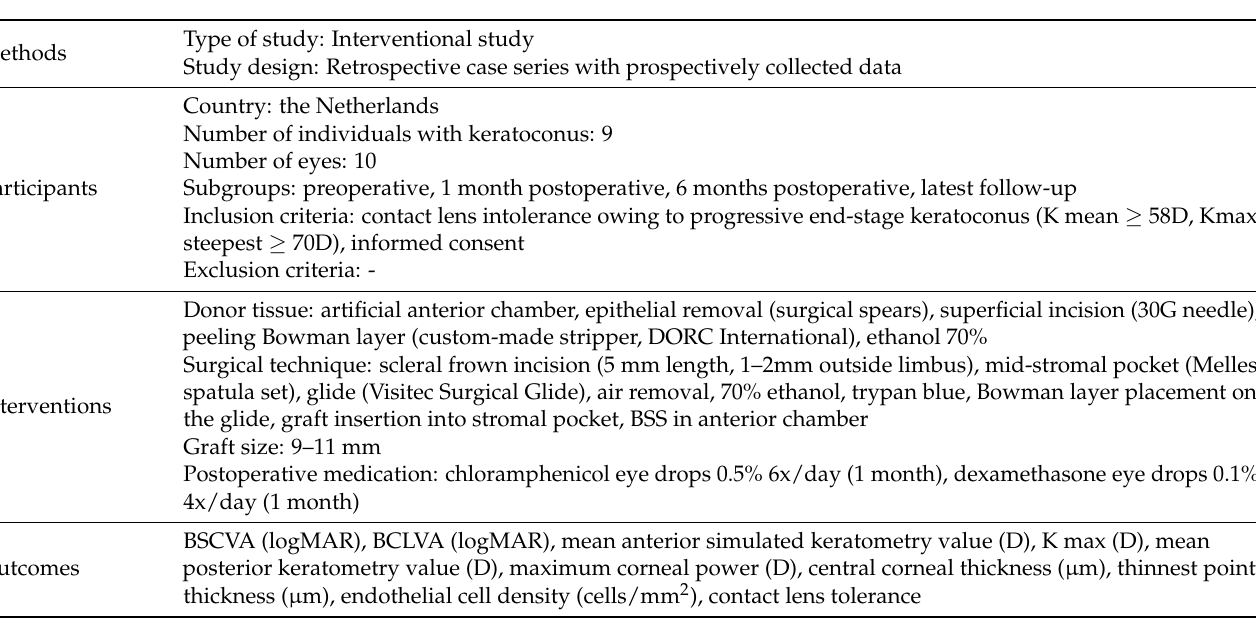
Table A16. van Dijk 2014 [27].